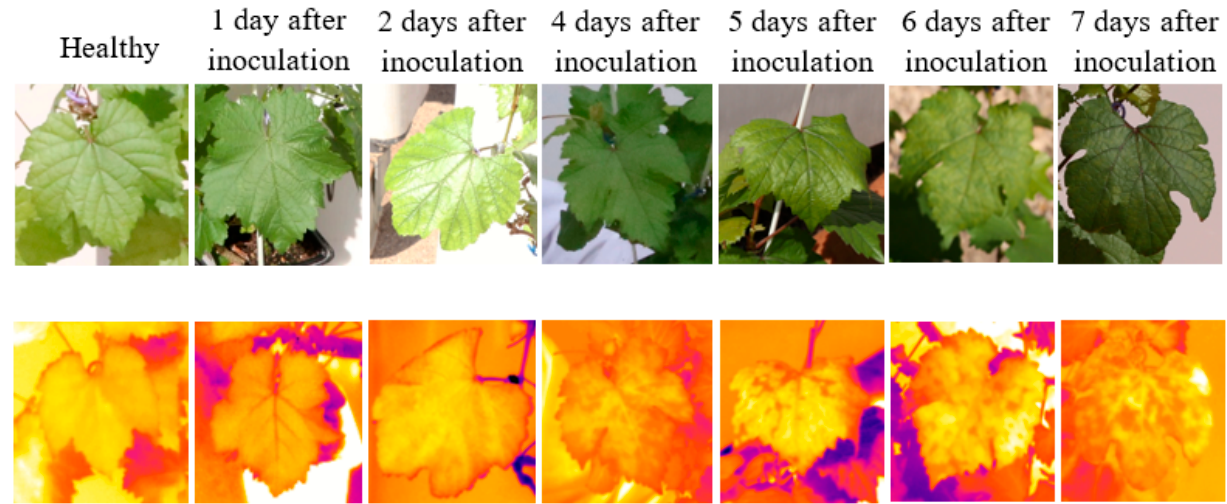
Figure 2. Examples of RGB images ( top row ) and thermal images ( bottom row ) of different leaves from different infected days.